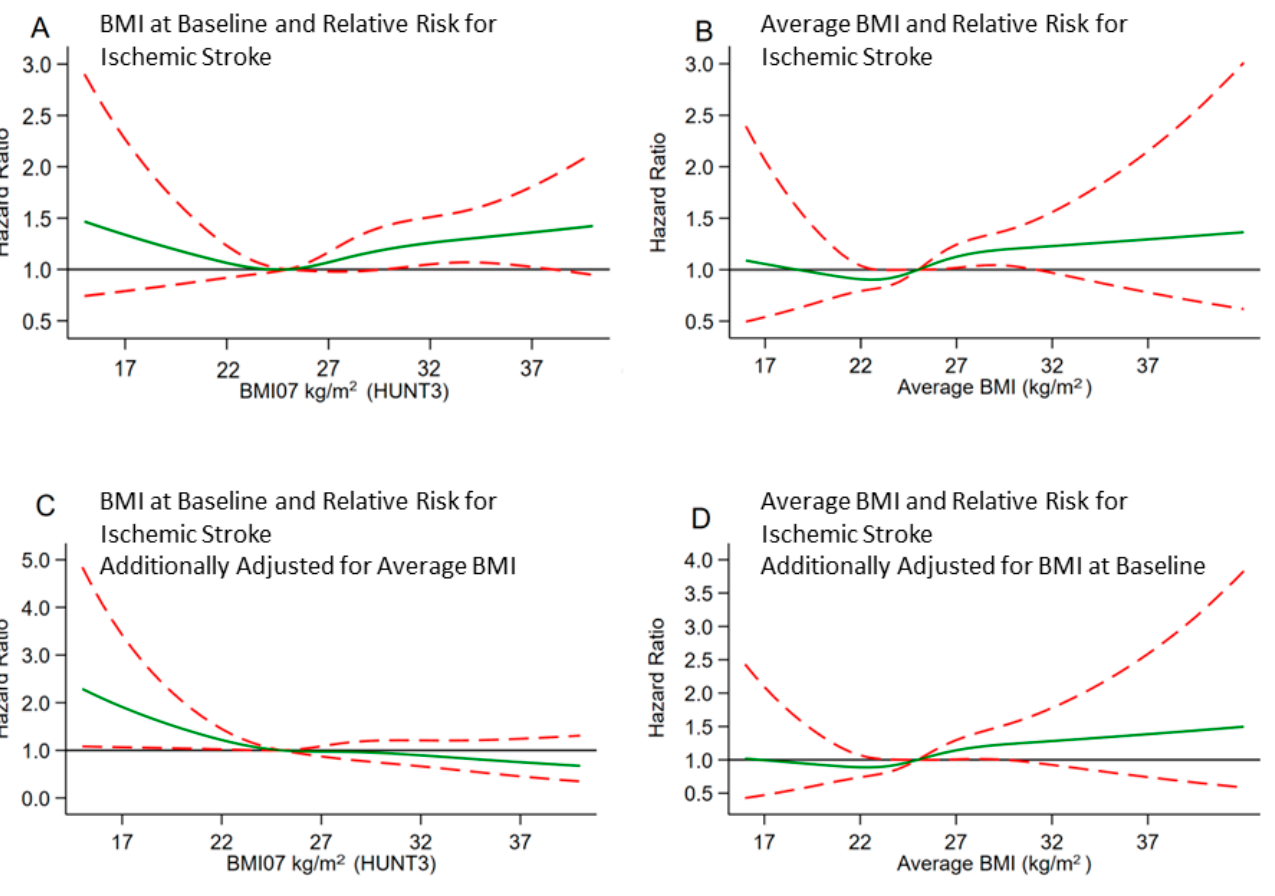
Figure 2. ( A to D ): Cubic Splines of BMI at Baseline or Average BMI (BMI 67-07 ) and HR of Ischemic Stroke. All Splines are Adjusted for Covariates of Model 2. ( C ) is Additionally Adjusted for Average BMI (BMI 67-07 ) and ( D ) for the Most Recent BMI from Baseline HUNT3.